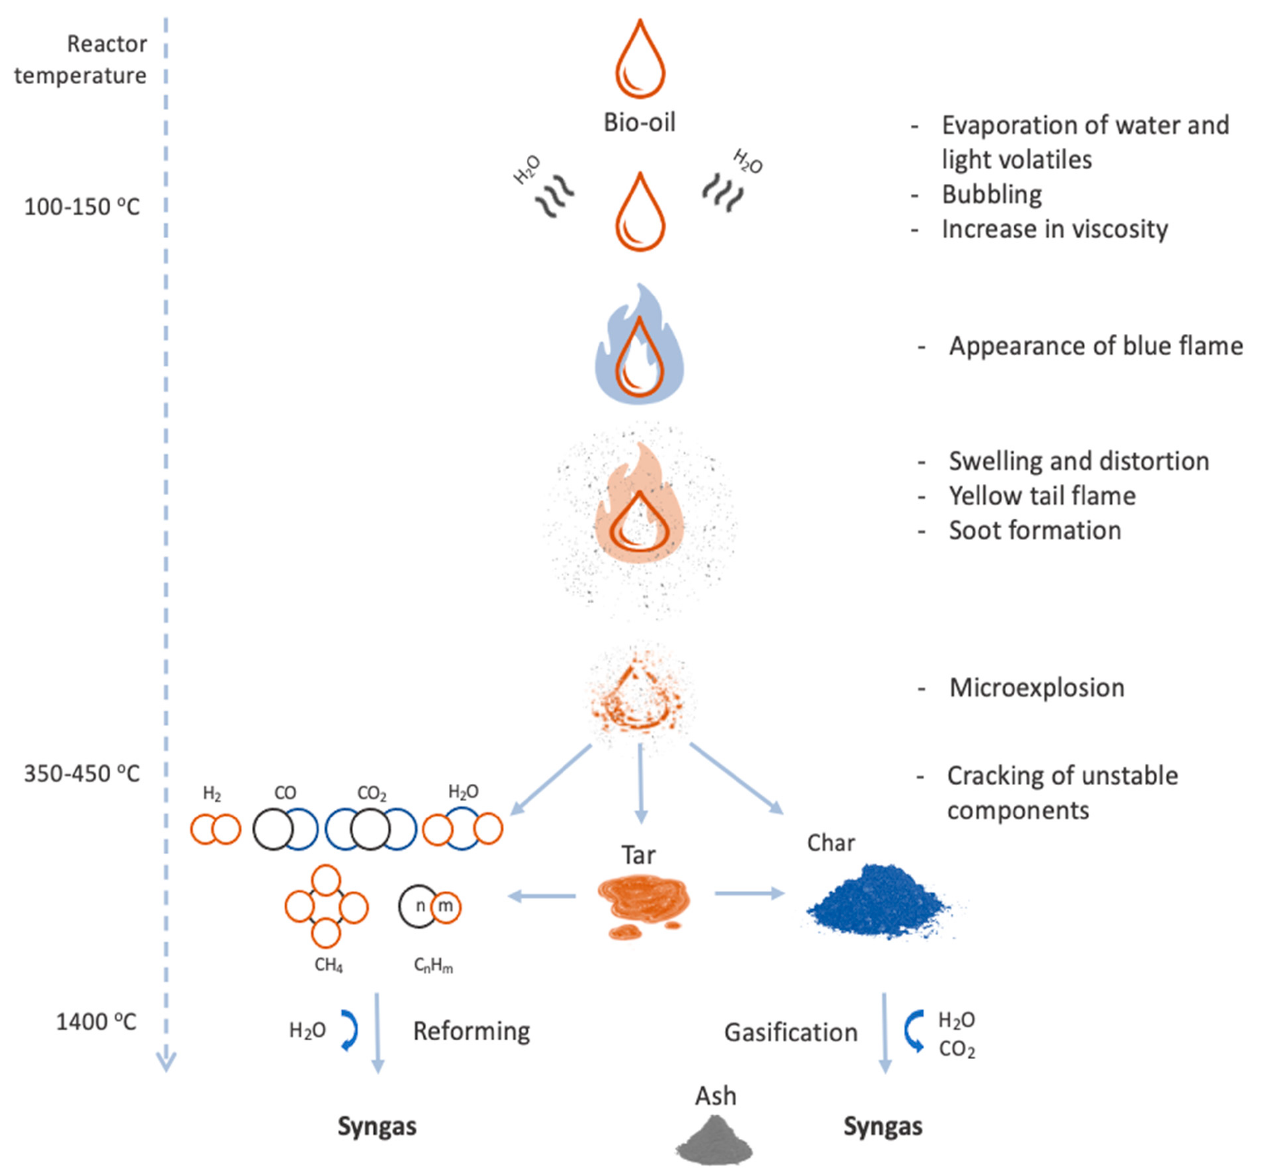
Figure 6. Schematic representation of gasification.